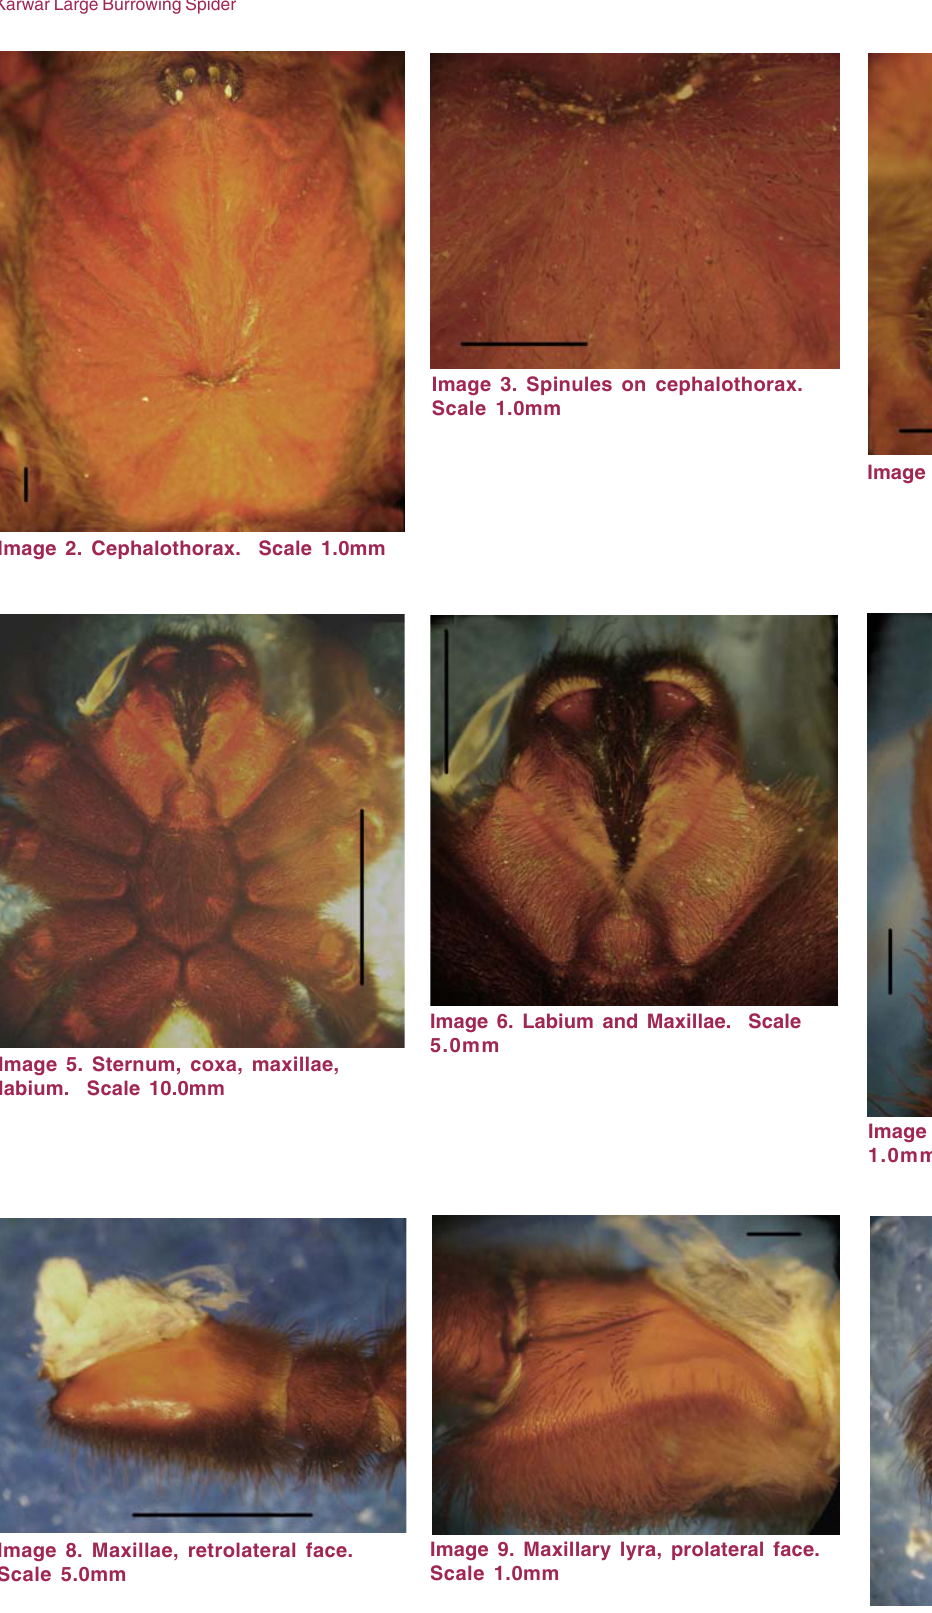
Image 10. Chelicerae, prolateral face. Scale